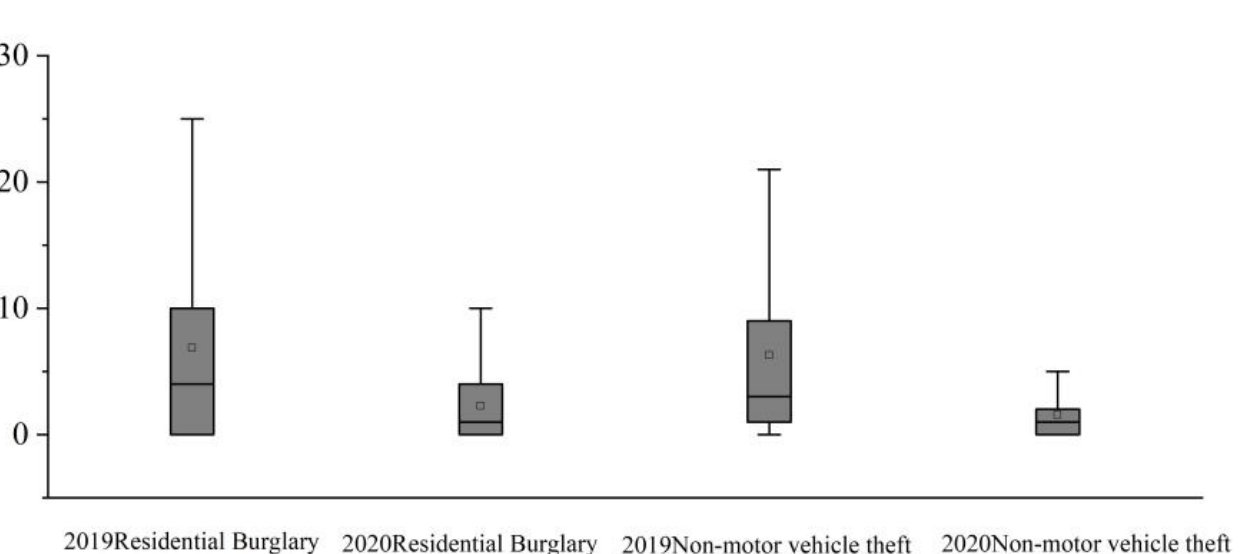
Figure 3. Spatial distribution of residential burglary and non-motor vehicle theft measured by AJPSs during the pre- (2019) and pandemic (2020) periods.